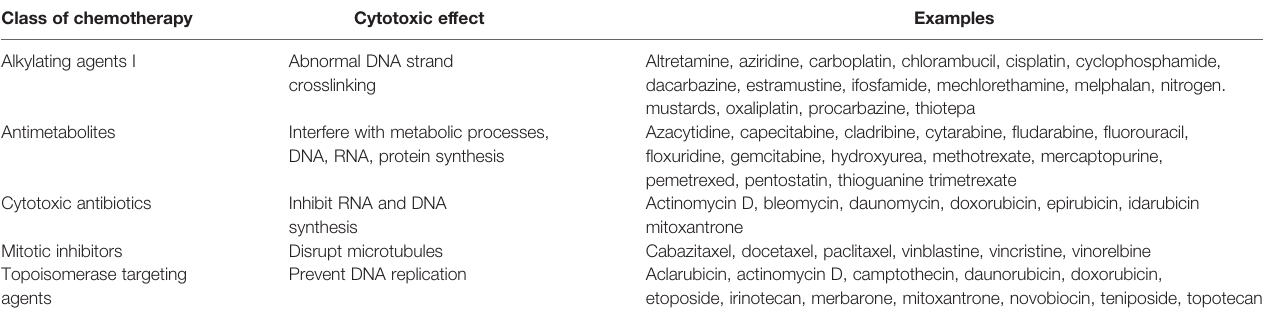
TABLE 1 | Classes of conventional chemotherapy